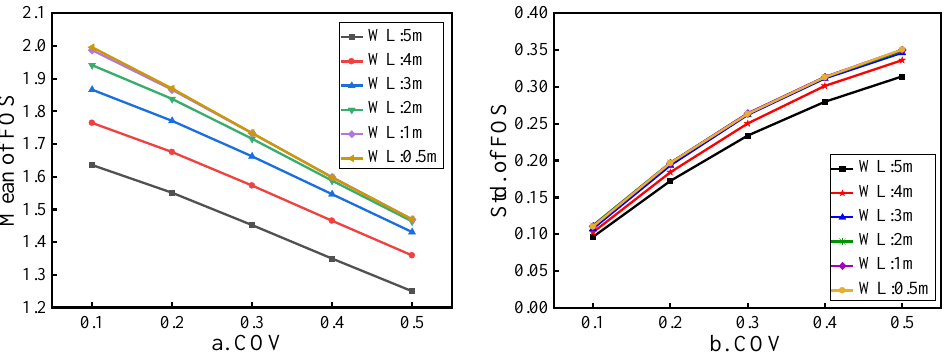
Figure 13. FOSs vs. COV of shear strength for different WLs ( l x = 50 m) (( a ) The Mean of FOS for six different WLs; ( b ) The Std. of FOS for six different WLs).